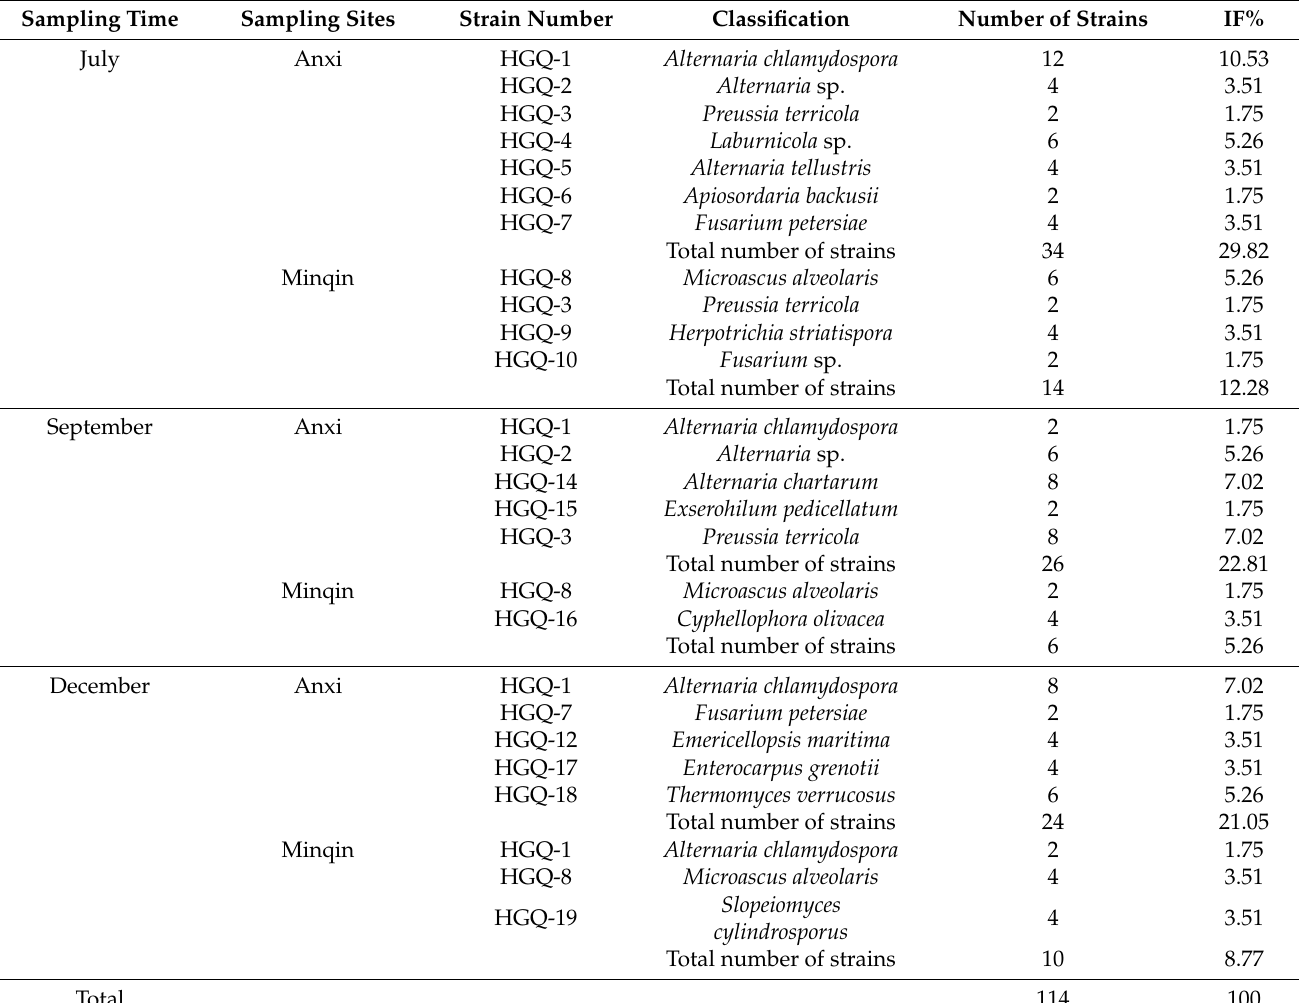
Table 2. The number of isolates recovered and isolation frequency (IF) of DSEs in the roots of L. ruthenicum . Sampling